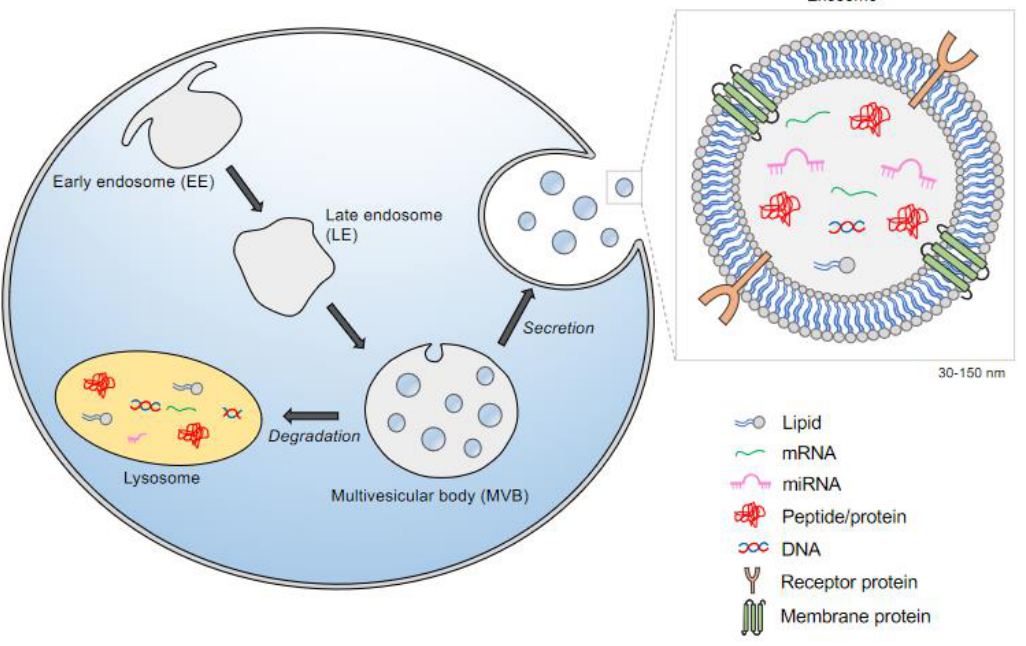
Figure 1. Intracellular biogenesis of exosomes. Exosomes can be formed through the endocytic trafficking pathway. These vesicles are generated by limited inward budding of the late endosome to form the intraluminal vesicles (ILVs). ILVs are components of multivesicular bodies (MVB). Two routes can occur at the MVB: 1. Degradation, resulting from fusion with lysosomes and 2. Secretion, that takes place when multivesicular bodies (MVBs) fuse with the plasma membrane and release their contents into the extracellular space. Secreted exosomes can be captured by nearby or distant cells and regulate the physiological state of the recipient